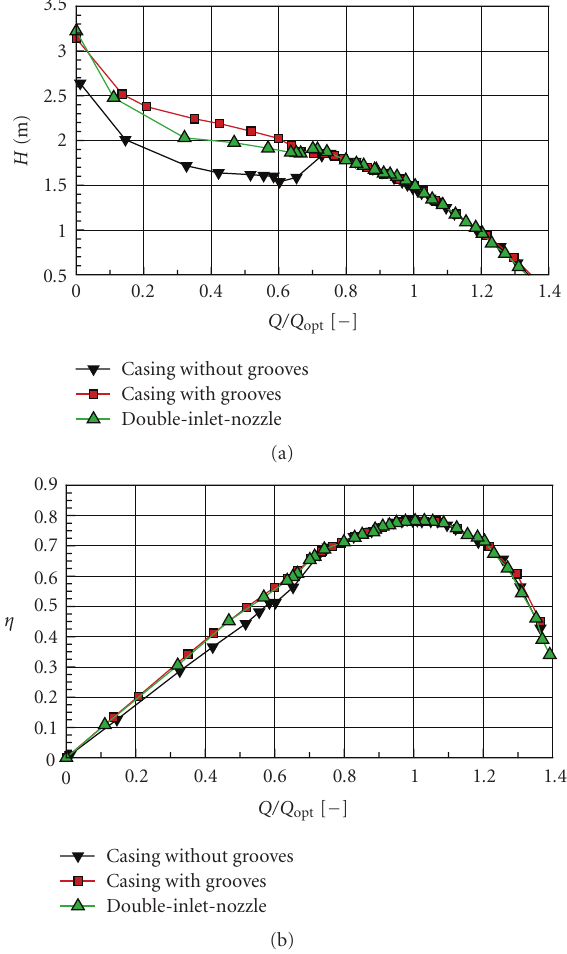
Figure 8: Pump head (above) and pump e ffi ciency (below) of original smooth casing, grooved casing and